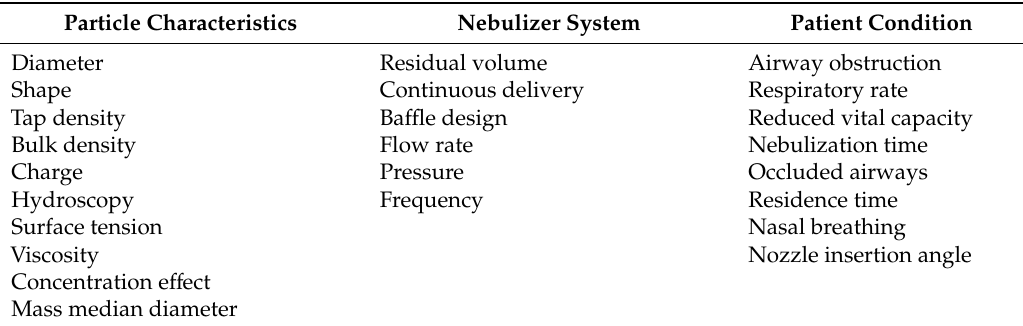
Table 1. Factors influencing outputs of